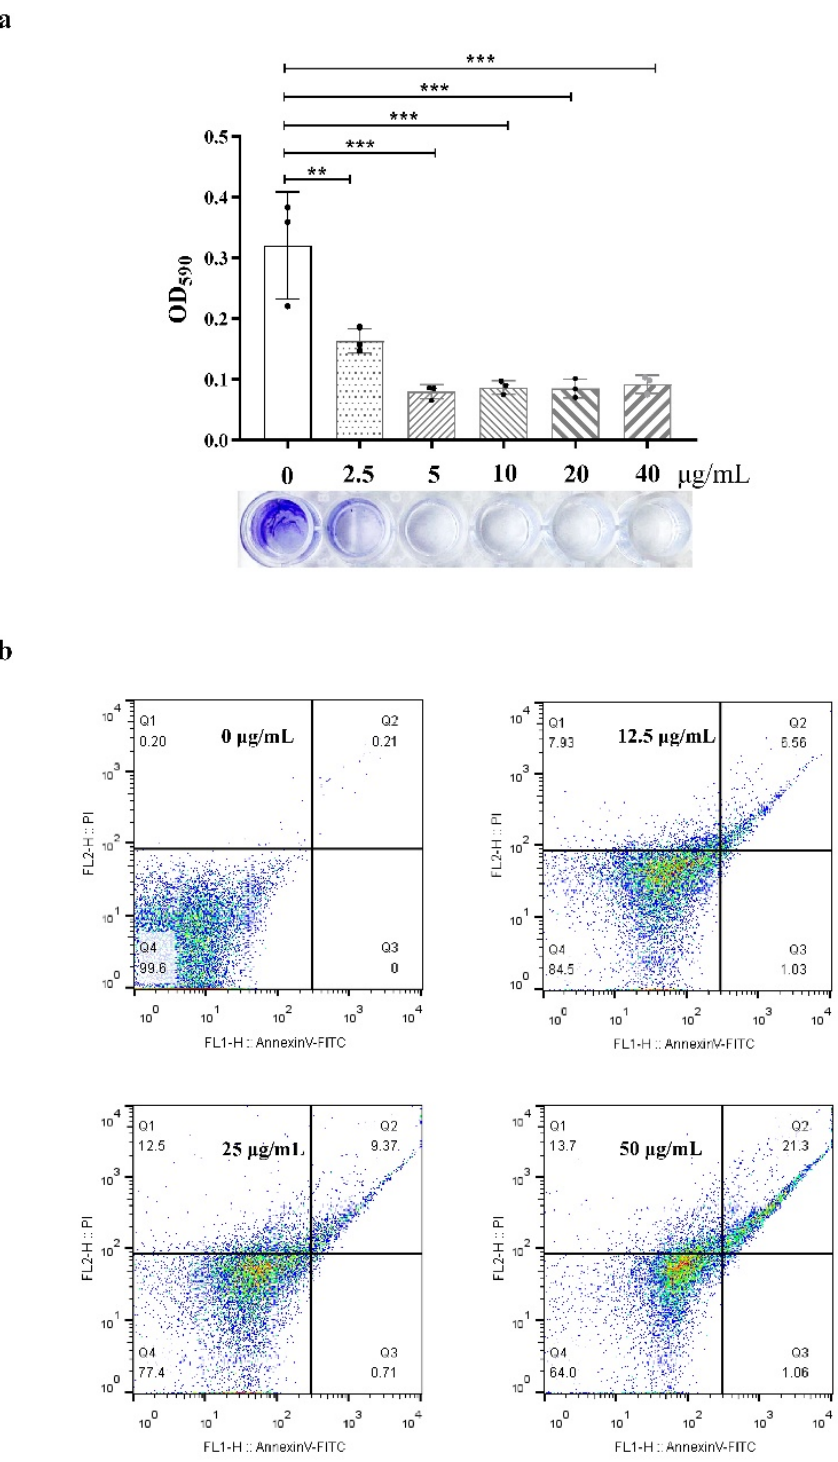
Figure 3. ( a ), Biofilm formation (crystal violet staining); the test concentrations were 40, 20, 10, 5.0, and 2.5 µ g/mL and the absorbance value of crystal violet was measured at 590 nm. ** for p < 0.01, *** p < 0.001, One-way ANOVA followed by Dunnett’s multiple comparisons test was performed using GraphPad Prism. ( b ), Apoptosis detection (PI and AnnexinV-FITC staining); the test concentrations were 50, 25, and 12.5 µ g/mL. Q1 means necrosis cell, Q2 means late apoptosis, Q3 means early apoptosis, and Q4 means live bacteria.